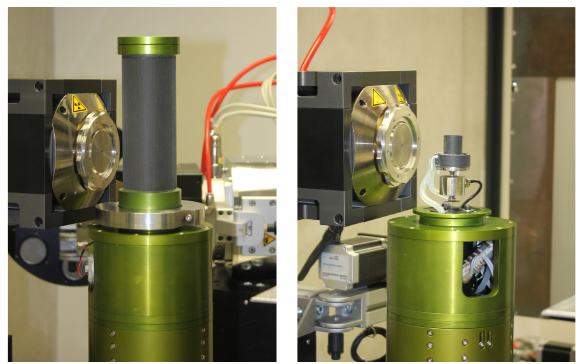
Figure 2. Environmental in-situ stage in closed car- bon tube (left) and open state (right).